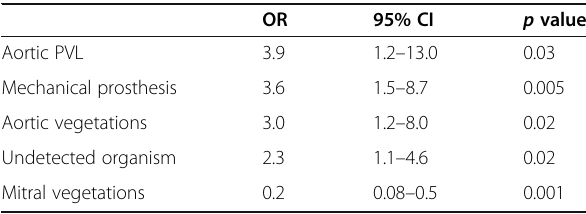
Table 2 Logistic regression analysis for significant variables associated with ARA